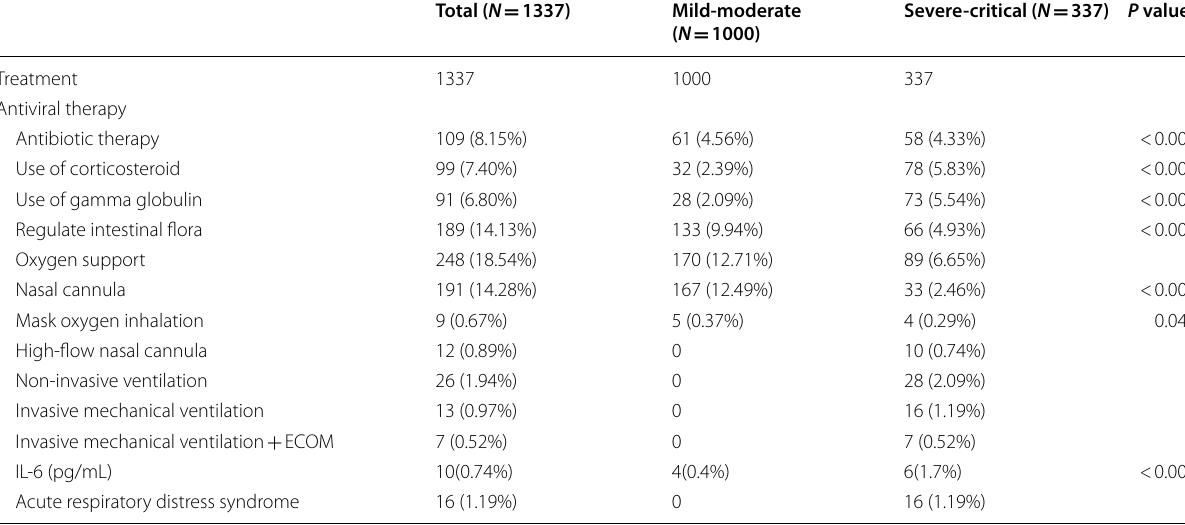
Table 4 The treatment of patients who are progressing and those who are stable